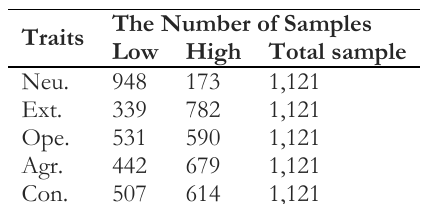
Table 2. The number of short audio clips at high and low levels in